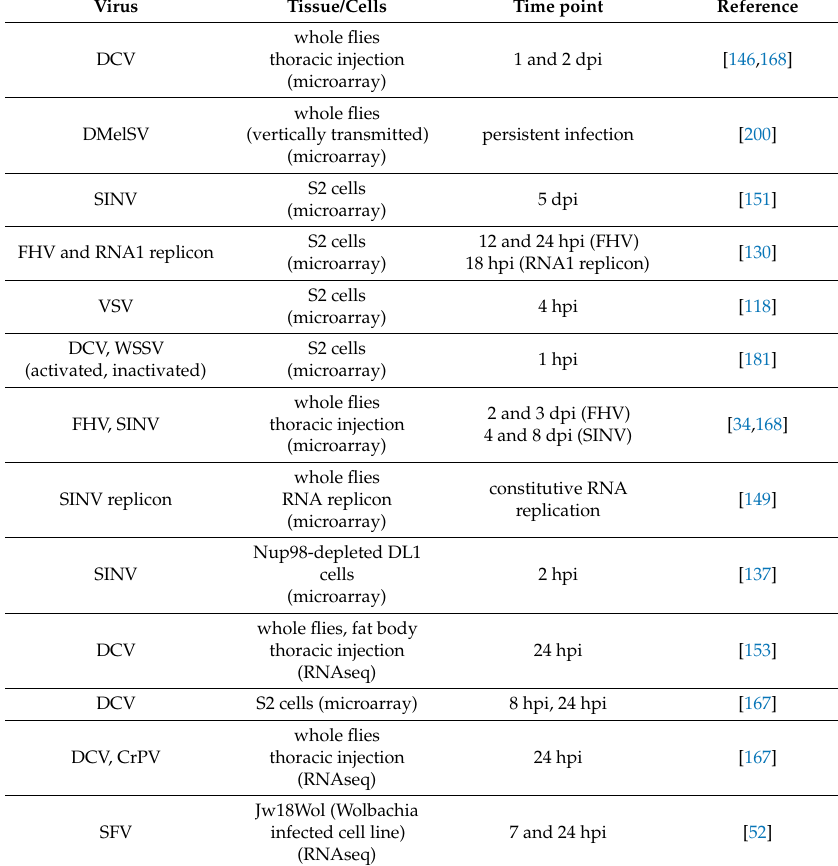
Table 2. Overview of transcriptome studies following viral infection in Drosophila adult flies or tissue culture cells. The method used for genome-wide transcriptome analysis is also indicated (microarray, RNAseq). Abbreviations: DCV, Drosophila C virus; DMelSV, Drosophila melanogaster Sigma virus;